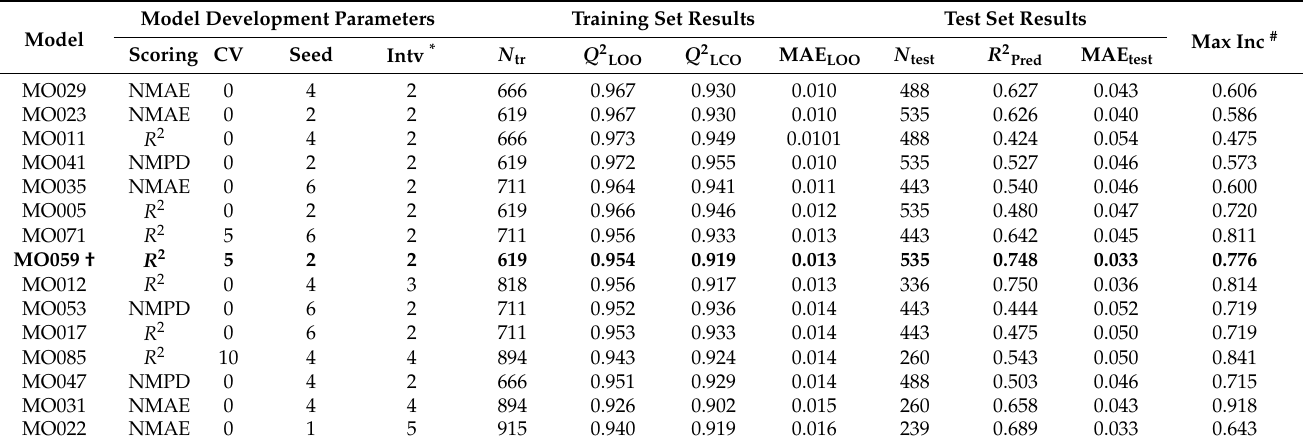
Table 1. Summary of statistical performance of the top 15 models (according to MAE LOO values) obtained from MO-based data